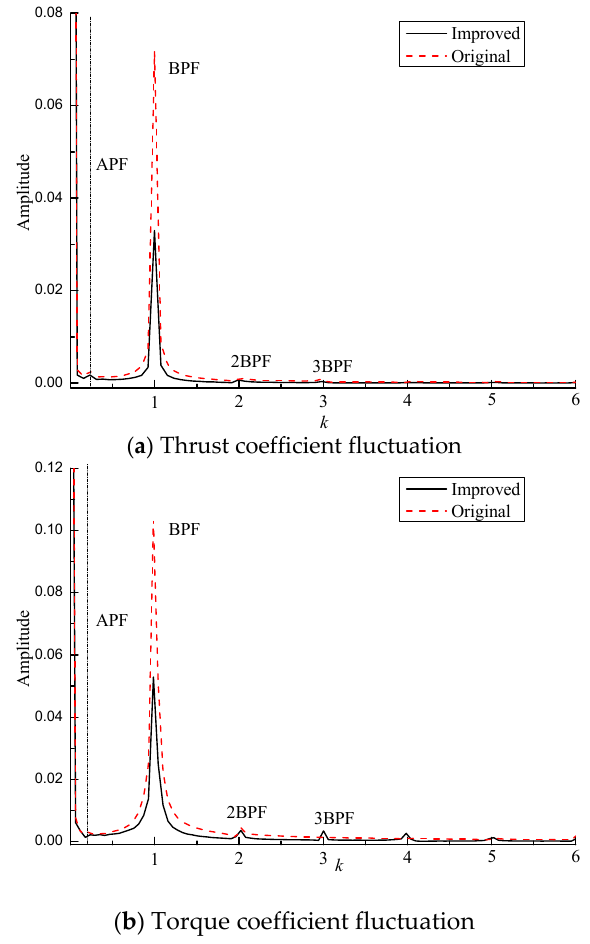
Figure 12. Time–domain fl uctuation curves of propeller loads.